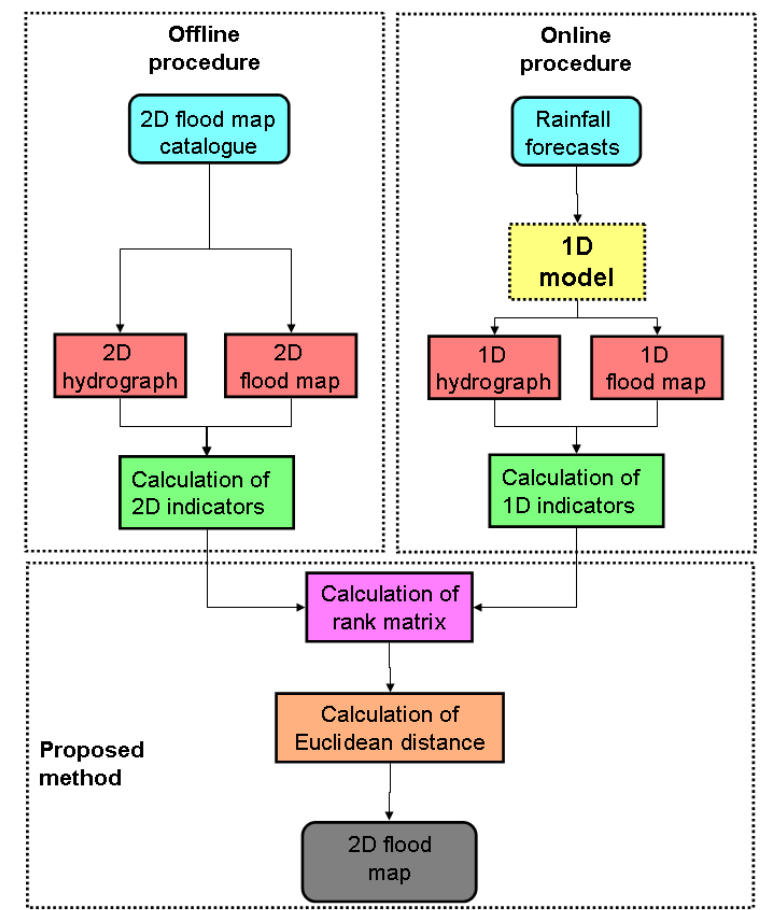
Figure 13. Flow chart of an online early-warning platform for flood forecasting using the proposed